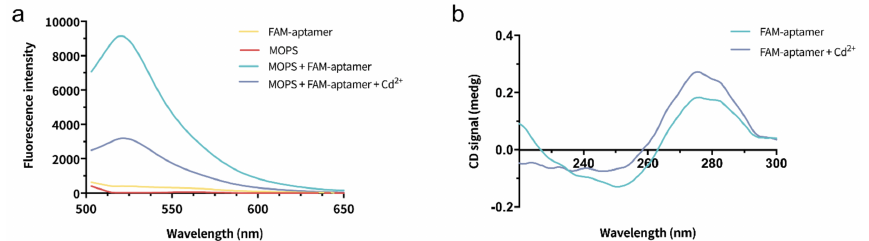
Figure 1. ( a ) Fluorescence emission spectra of FAM-aptamer, MOPS, MOPS + FAM-aptamer, and MOPS + FAM-aptamer + Cd 2+ (FAM-aptamer, 20 nM; MOPS, 5mM, pH 9.0; Cd 2+ , 200 ng mL − 1